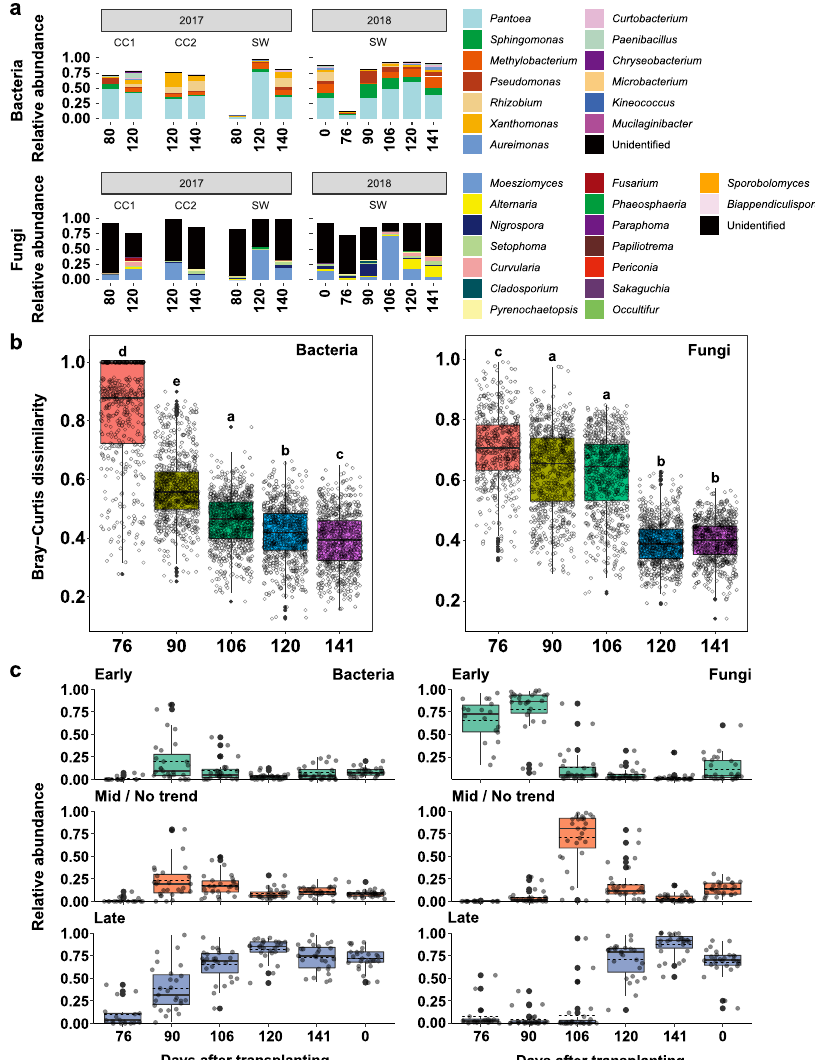
Fig. 2 Distribution and successional changes of vertically transmitted bacterial and fungal communities. a Relative abundance of vertically transmitted bacterial and fungal communities during seed development. Mean relative abundances of bacterial and fungal OTUs were estimated at the genus level. Exact values of relative abundances and standard deviations are available in Supplementary Data 2. Bar plots are depicted according to sampling year and geographic sites. The numbers in x -axis indicate sampling point (days after transplanting to fi elds). CC1, Chuncheon 1; CC2, Chuncheon 2; SW, Suwon. b Pairwise dissimilarity between vertically transmitted bacterial and fungal communities in parent seeds (Se0) and progeny seeds collected from 76 to 141 days after transplanting. Pairwise community dissimilarity was calculated using Bray-Curtis dissimilarity index. Boxes and lines in the boxes represent inter-quantile range (Q3 – Q1) and median of dissimilarity values, respectively. Black- fi lled dots indicate potential outliers. Lower and upper whiskers show minimum and maximum values of community dissimilarity in each comparison pair. Statistical signi fi cance of each compartment by rice age was estimated using Kruskal-Wallis test with two-sided Dunn ’ s test since dissimilarity values did not meet the normal distribution (Shapiro-Wilk normality test, P < 2.2e- 16 for bacteria and fungi). The letters indicate statistical signi fi cance ( P < 0.05). The statistical results are available in the source data in Supplementary Data 2. c Successional changes of cumulative relative abundance of vertically transmitted bacterial and fungal communities. Succession modes were classi fi ed based on linear regression between time and relative abundance of each OTU (Early, t < 0, P < 0.05; Mid/no trend, P > 0.05; Late, t > 0, P < 0.05). The numbers in x -axis indicate sampling point (days after transplanting to fi elds). The number 0 indicates parent seeds. The other numbers indicate progeny seeds. Boxes and lines in the boxes represent inter-quantile range (Q3 – Q1) and median of cumulative relative abundances of OTUs in the succession groups in each time, respectively. Black dashed lines in the boxes indicate the mean cumulative relative abundances. Black- fi lled and gray dots indicate potential outliers and the cumulative relative abundances in each biological replicate ( n = 18 for 76 days after transplanting; n = 27 for 90 – 141 days after transplanting), respectively. Lower and upper whiskers show minimum and maximum relative abundance